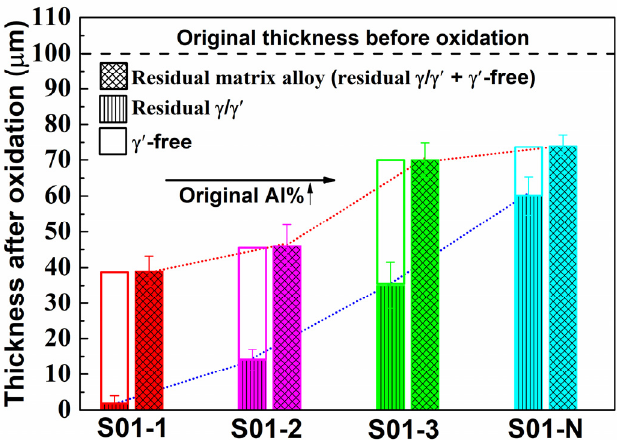
Figure 9. Thicknesses of the residual matrix alloy region in the thin specimens (thickness of 0.1 mm) with different original Al contents after 100 h of isothermal oxidation at 1100 °C. The thicknesses of the residual γ / γ ’ zone and the γ ’ − free zone, which make up the residual matrix alloy region, are also plotted.